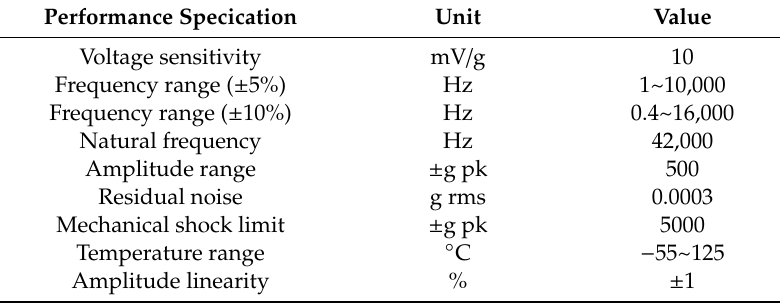
Table 3. The main parameters of the eddy current sensor.